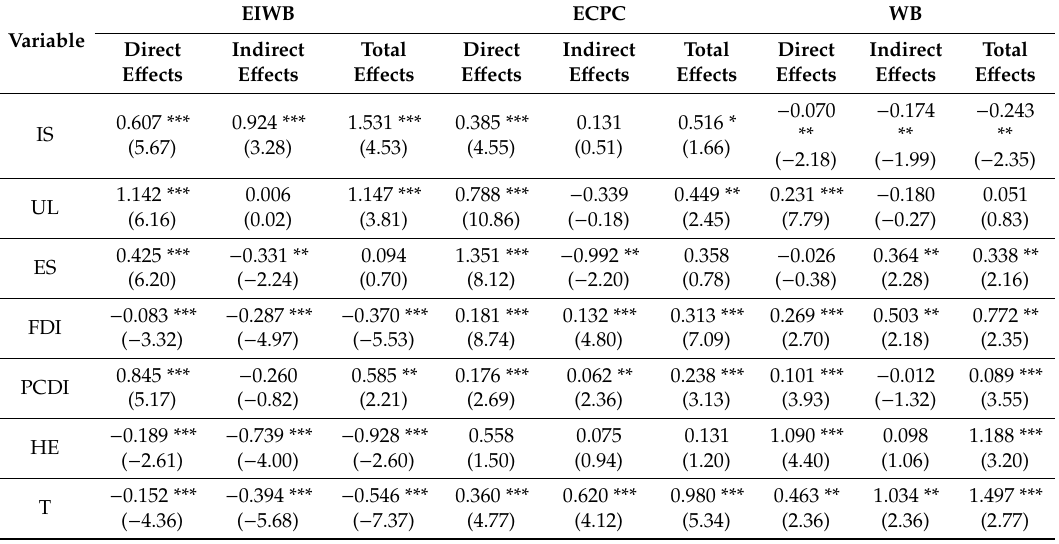
Table 6. Direct, indirect and total e ff ects of the spatial Durbin